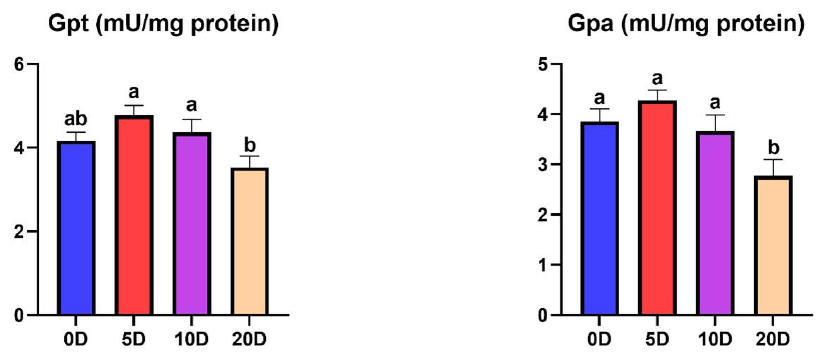
Figure 6. Means ± SEM of the enzyme activities ( n = 18 per treatment) related to glycogenolysis metabolism in the liver. a, b Different letters indicate significant differences between the pre-slaughter times ( p < 0.05). GPt: total glycogen phosphorylase; GPa: activated glycogen phosphorylase.